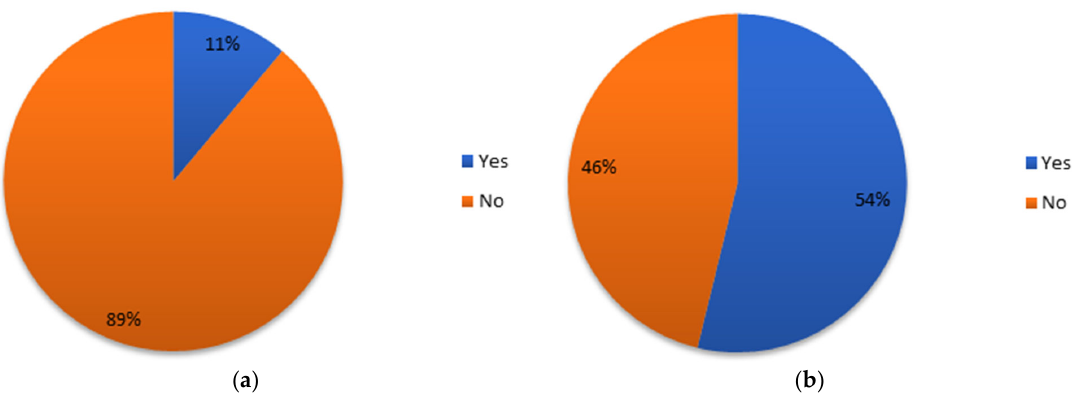
Figure 5. Estimation of automatic segmentation solutions being a menace for radiation oncologists ( a ) and young radiation oncologists training ( b ).